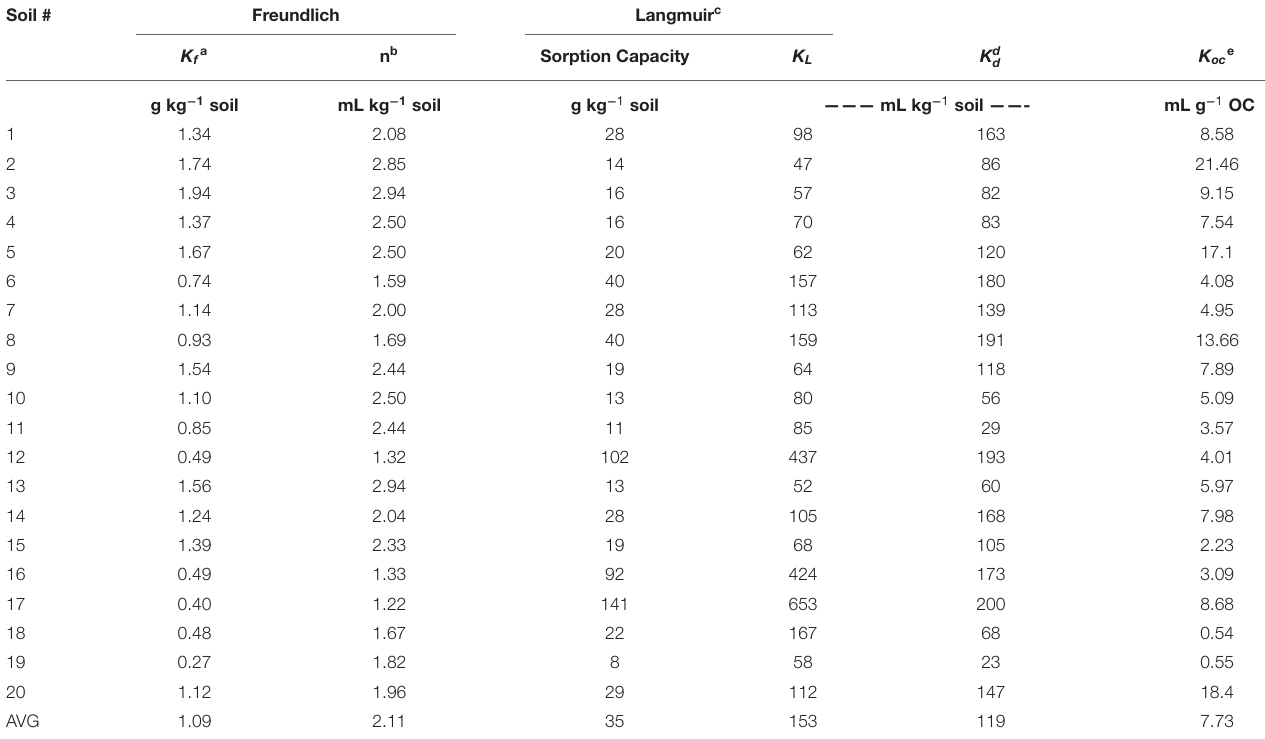
TABLE 2 | Sorption capacity and sorption coefficients K d and K oc of ciprofloxacin in soils used in this study. Soil #